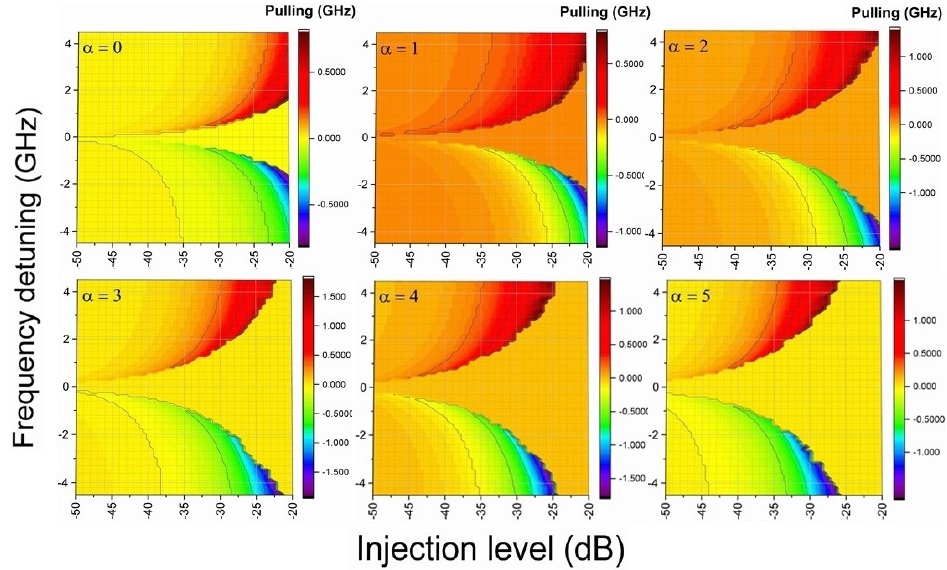
Figure 1. Injection locking map for six values of the LEF (0 − 5), showing the intensity of frequecy pulling at both edges of the locking region.